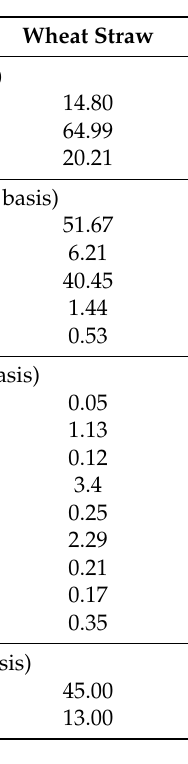
Table 2. Properties of sludge and wheat